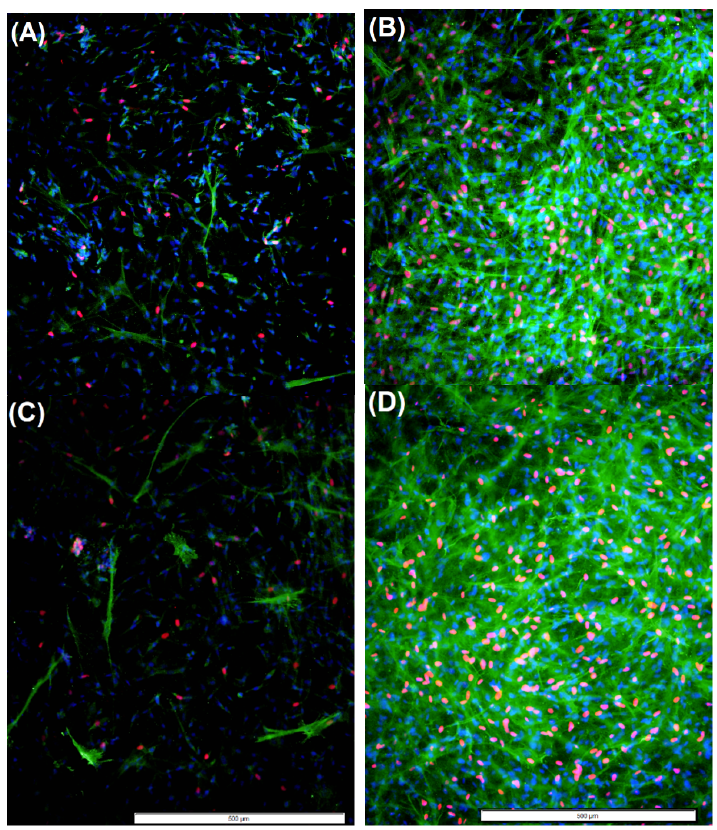
Figure 7. TGF-β1 increases proliferation and myofibroblast differentiation in aFPCM incorporating chitosan derivatives. Immunostaining was used to identify non-proliferating myofibroblasts (green cytoplasmic fibers with blue nuclei), proliferating myofibroblasts (green fibers and pink nuclei), nonproliferating fibroblasts (blue nuclei, and little or no cytoplasmic stain) and proliferating fibroblasts (pink nuclei only). Pink nuclei and green cytoplasmic fibers were abundant in TGF-β1 treated water control aFPCM ( B ) compared to no TGF-β1 treatment ( A ). GC-aFPCM in control conditions ( C ) stained similar to water control aFPCM ( B ), while TGF-β1 treatment increased proliferation and myofibroblasts in GC-aFPCM ( D ) similar to water control ( B ).